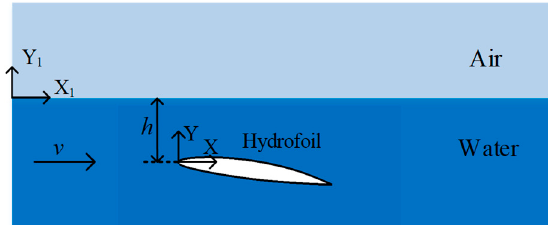
Figure 4. Definition of the coordinate systems in the computational domain.